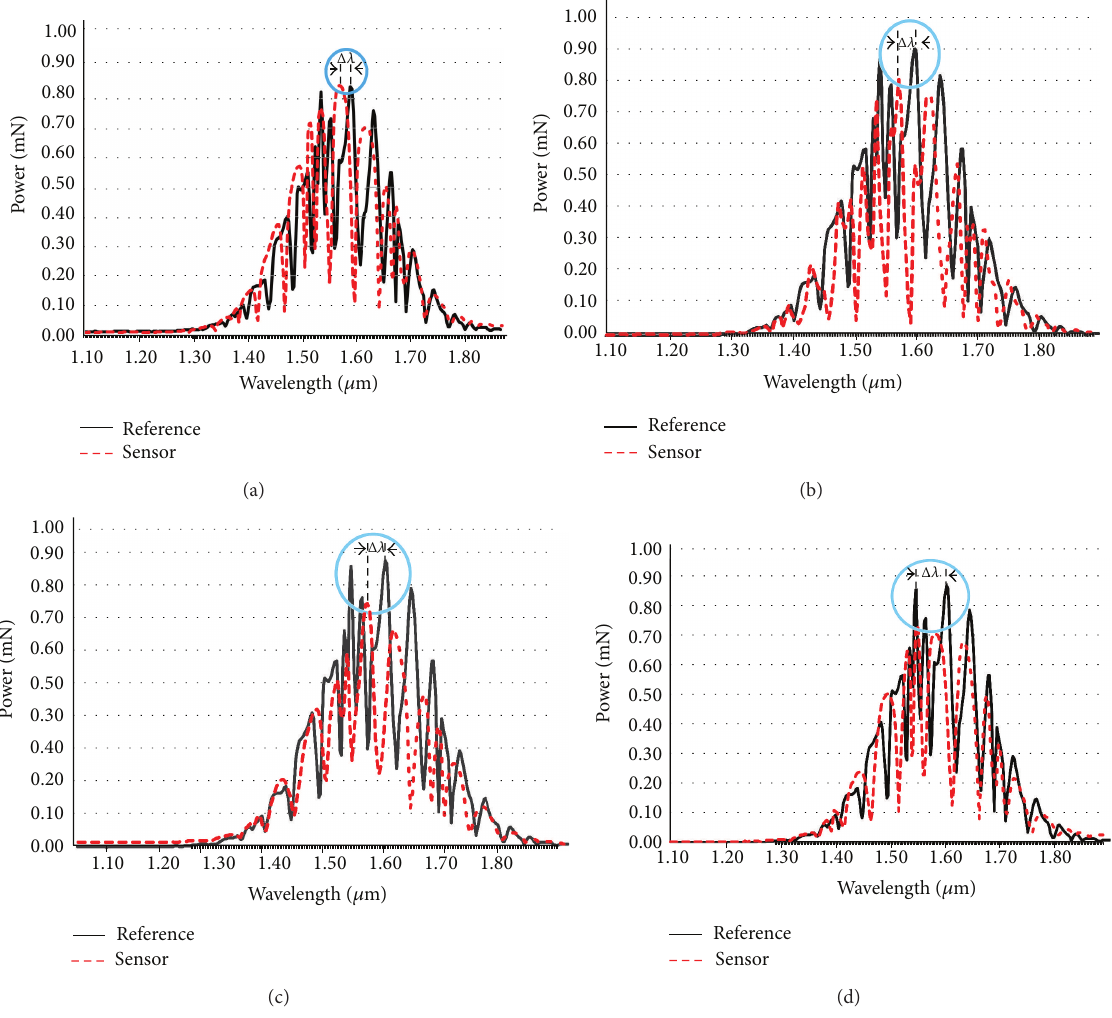
Figure 2: The relationship between interference signals of reference signals ( 𝐸 𝑅 signals ( 𝑅 2 is varying from 1.65 to 1.95 𝜇 m, red line), (a) 𝑅 2 = 1.552 𝜇 m, (b) 𝑅 2 = 1.554 𝜇 m, (c) 𝑅 2 = 1.556 𝜇 m, and (d) 𝑅 2 = 1.558 𝜇